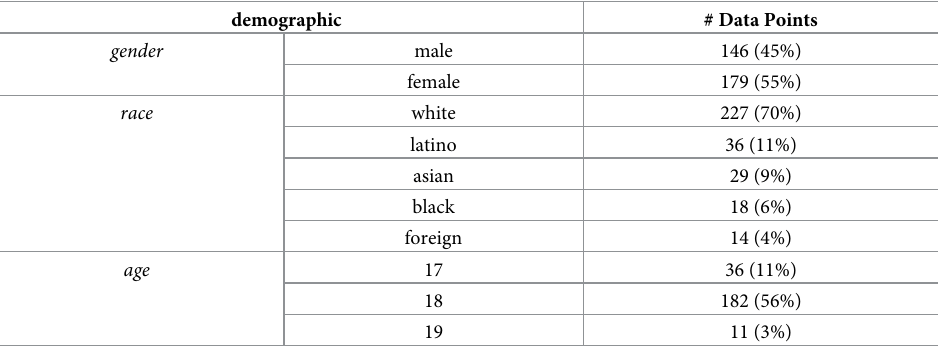
Table 1. Summary of demographics in data